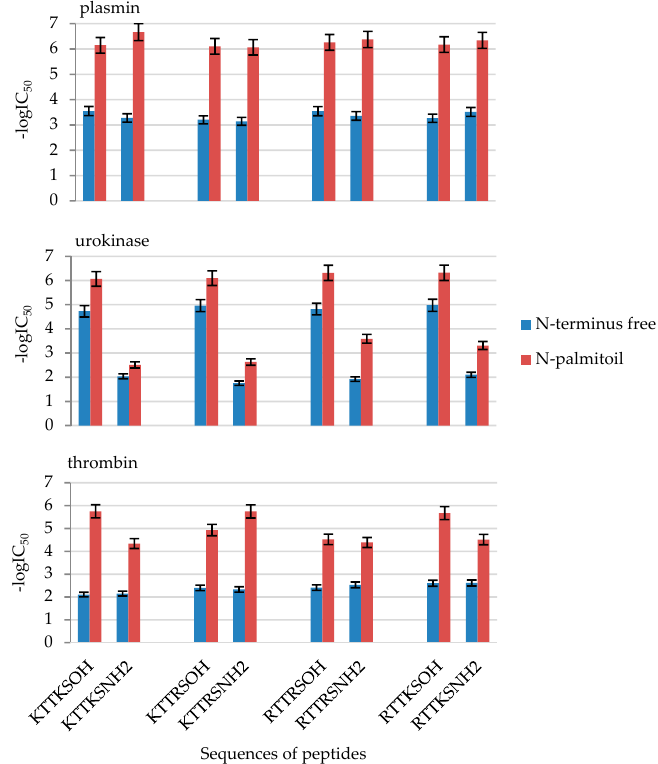
Figure 8. Influence of the introduction of N-terminal palmitic group in the synthetized peptides on plasmin, urokinase and thrombin inhibition. Inhibition values in the form of -logIC 50 from Table